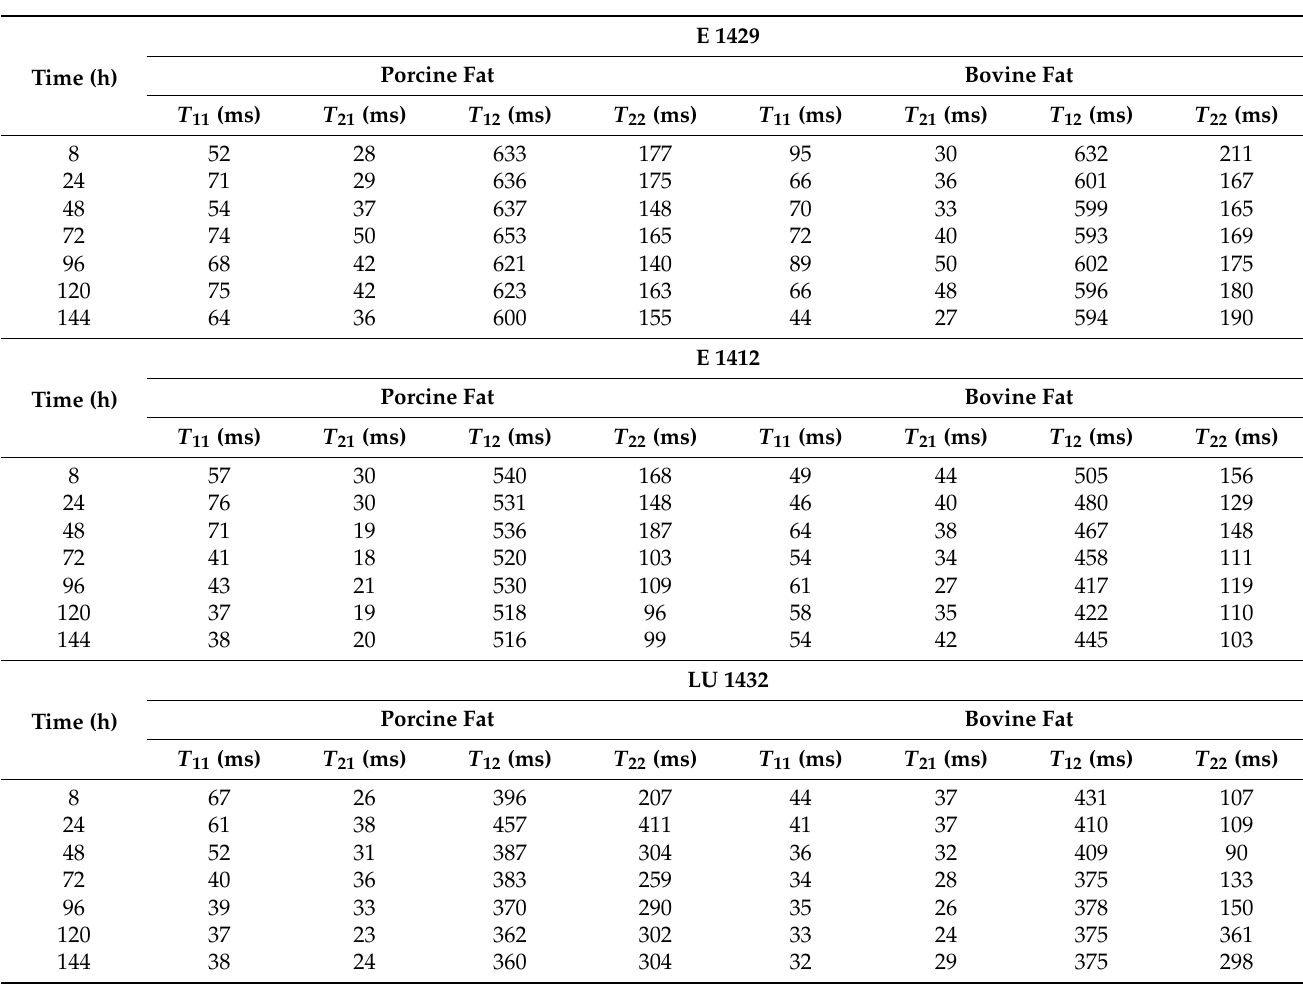
Table 4. Values of spin–network T 1 and spin–spin T 2 relaxation time components in O/W emulsions emulsified with modified potato